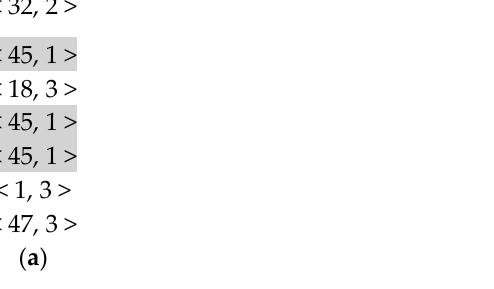
Figure 3. Population: ( a ) With twins and ( b ) after twin removal.